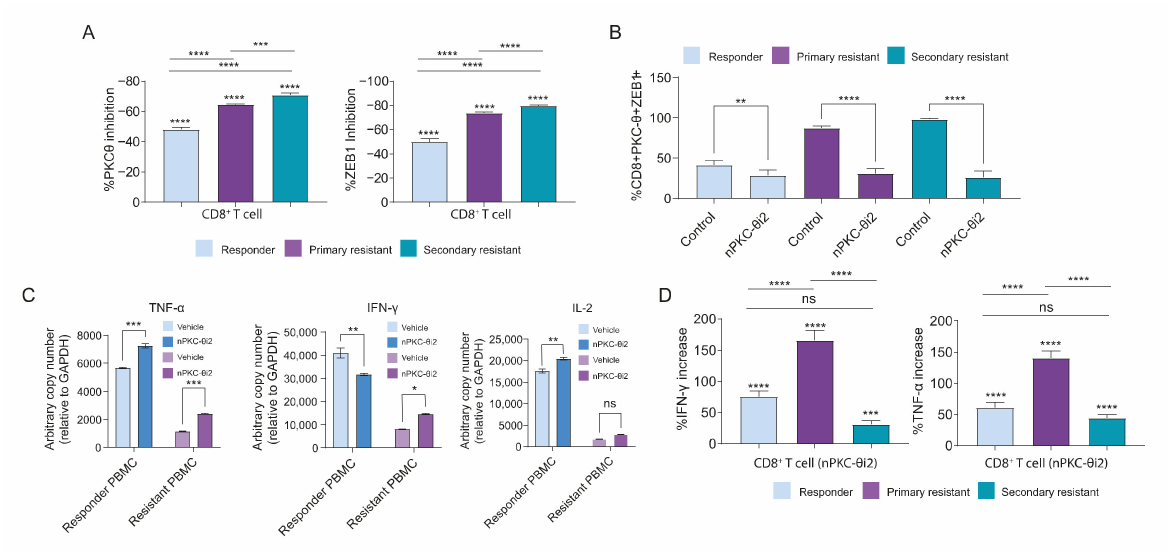
Figure 7. nPKC- θ i2 disrupts the nuclear ZEB1/PKC- θ complex and induces cytokine production in CD8+ T cells. ( A ) Graphs depicting the % inhibition or induction based on protein expression were also plotted for each protein target relative to untreated sample. ( B ) Percent of PKC- θ +/ZEB1+/CD8+ T cells in samples isolated from melanoma patients responsive (PR/CR) or primary/secondary resistant (PD) to immunotherapy. CD8+ T cells were treated with nPKC- θ i2 before activation ex vivo with PMA/ionomycin. ( C ) Gene expression of key effector cytokines IL2, IFNG, and TNFA in PBMCs isolated from resistant and responder patients either treated with vehicle control or nPKC- θ i2 before activation ex vivo with PMA/ionomycin. ( D ) Protein expression of TNF- α and IFN- γ in CD8+ T cells isolated from primary or secondary resistant or responder patient liquid biopsies and treated with nPKC- θ i2. Graphs show the % CD8+ increase in expression of TNF- α or IFN- γ in CD8+ T cells stimulated with PMA/ionomycin in addition to treatment with nPKC- θ i2. One-way ANOVA was used to compare groups, where ns (not significant), **** p < 0.0001, *** p < 0.001, ** p < 0.01, and * p <